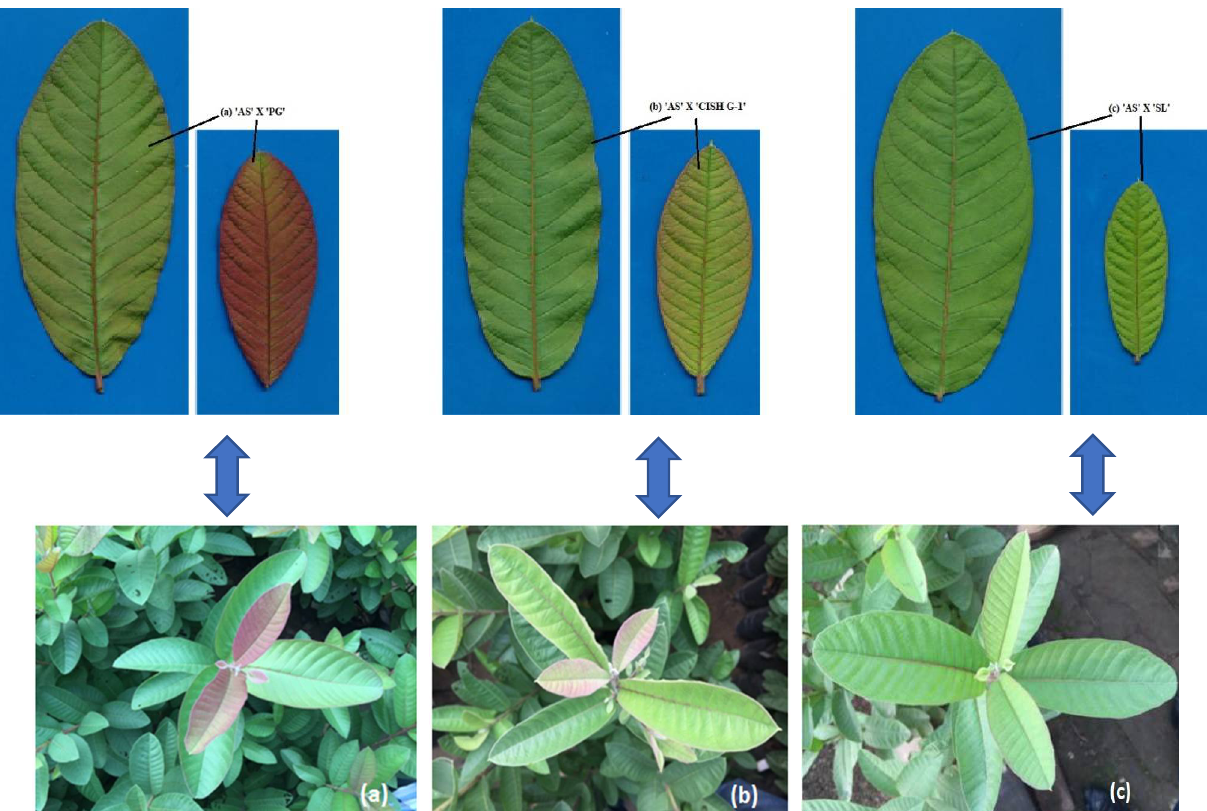
Figure 1. ( a ) Purple colouration in F1 individuals of ’AS’ × ‘PG’; ( b ) Light pink colouration in F1 individuals of ‘AS’ × ‘CISH G-1′ ( c ) Green colouration in F1 individuals of ‘AS’ × ‘SL’.